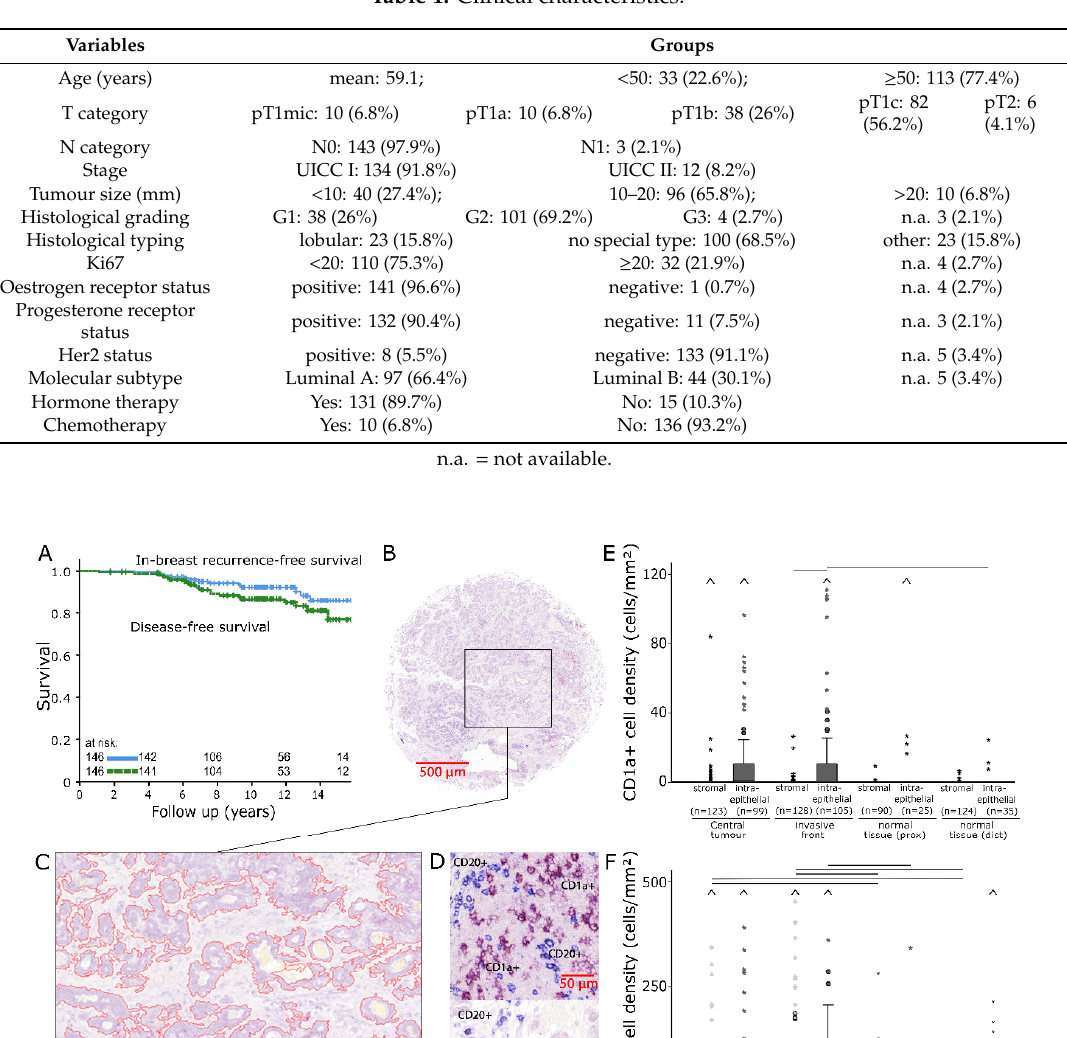
Table 1. Clinical characteristics.